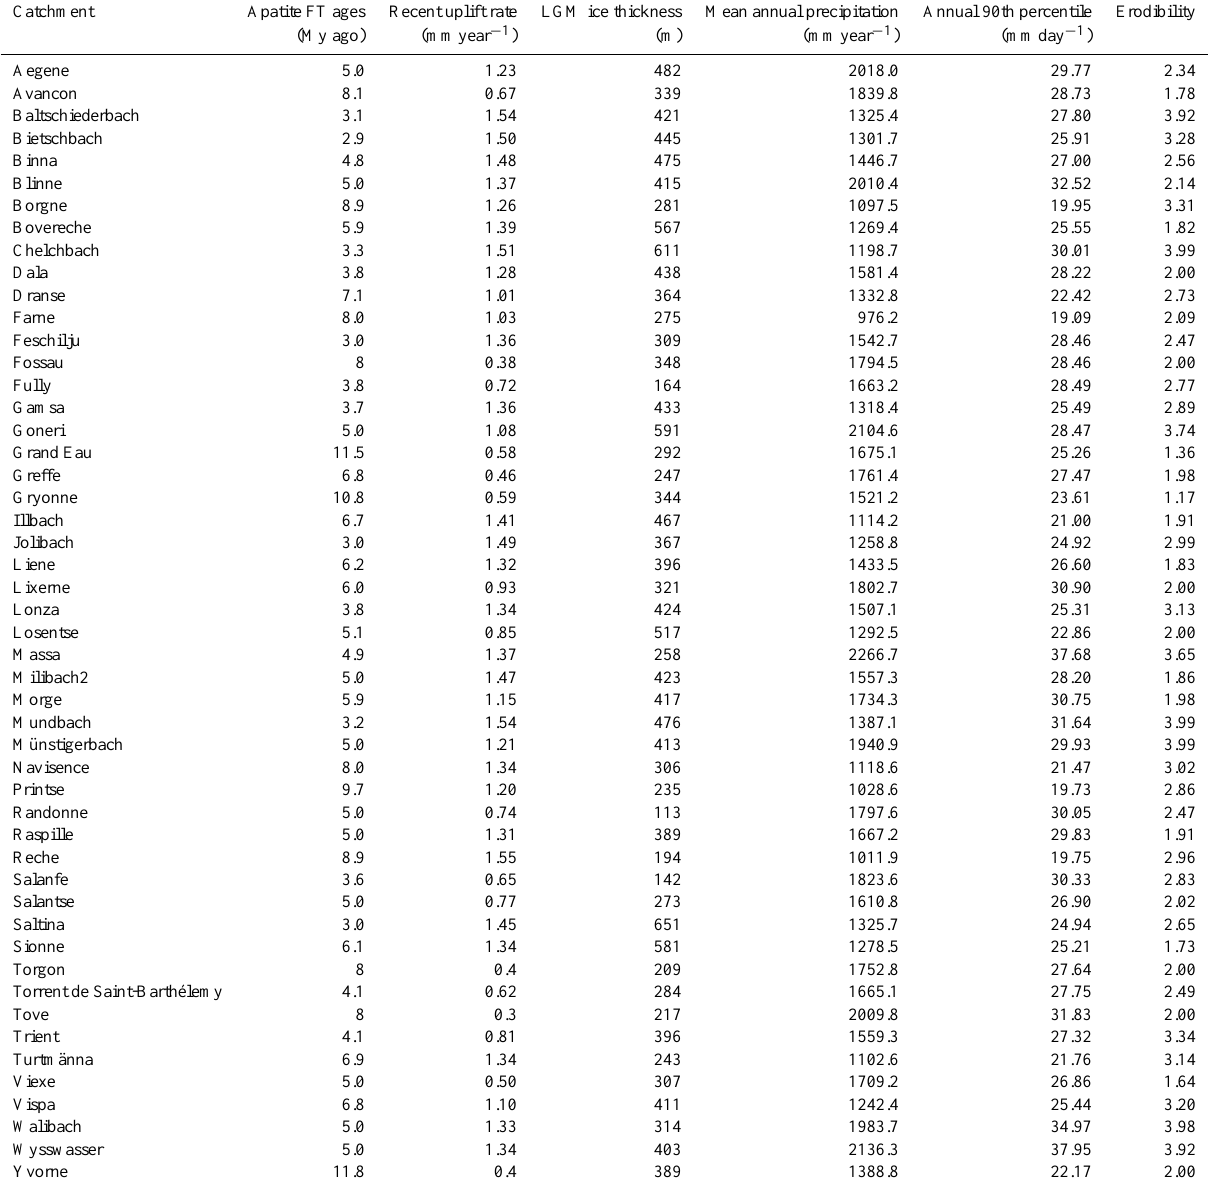
Table 2. Possibly controlling variables (2.2) extracted for the studied catchments.